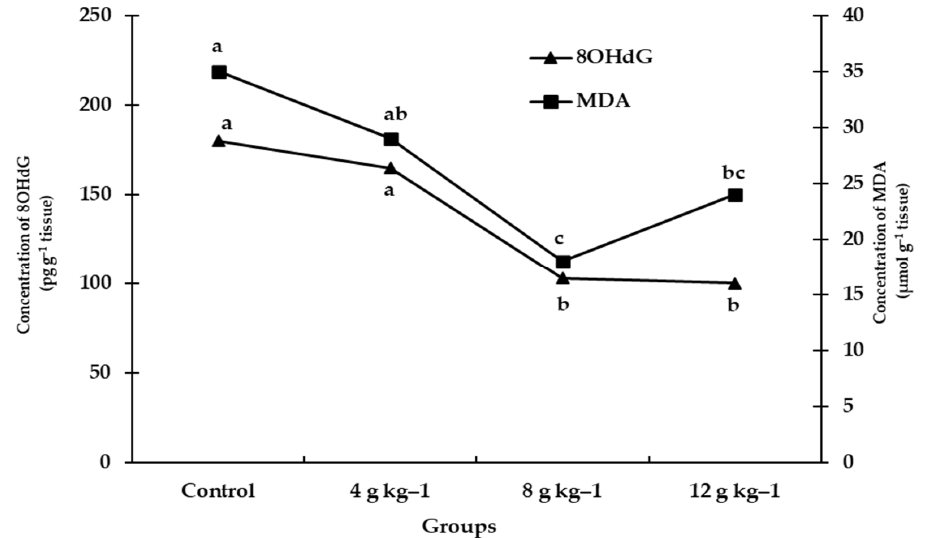
Means in each row superscripted by different alphabetic letters are significantly different ( p < 0.05); AST, Aspartate aminotransferase; ALT, Alanine Aminotransferase; TP, Total Protein; Alb, Albumin; Glob, Globulin; A/G, Albumin/Globulin.